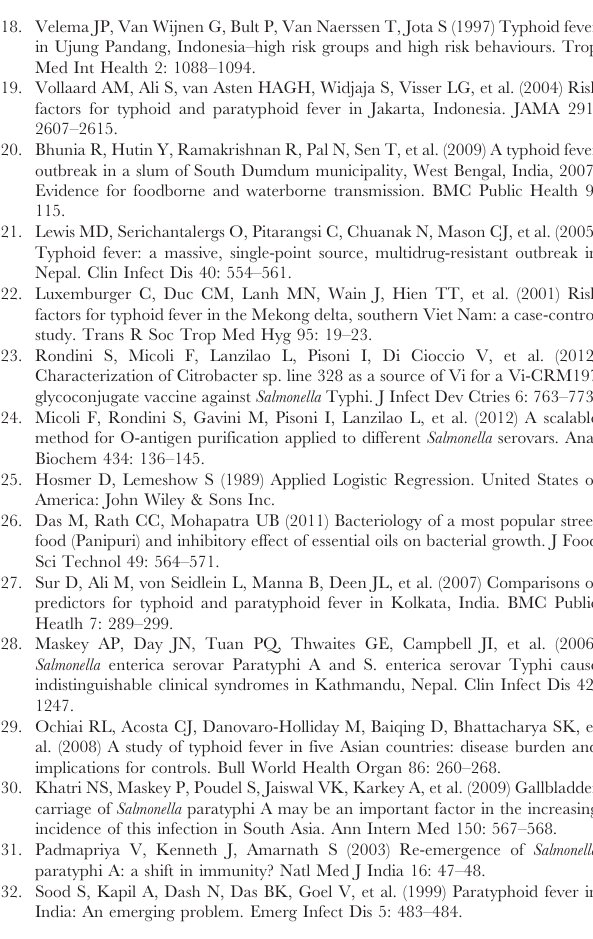
Table S1 Case-control questionnaire. A copy of the questionnaire administered to 103 cases and 294 controls in Patan Hospital and in the community, respectively, in a matched case control investigation conducted in Kathmandu, Nepal in 2011. There are a total of 131 questions detailing identification and demographic data, information on enteric fever exposures